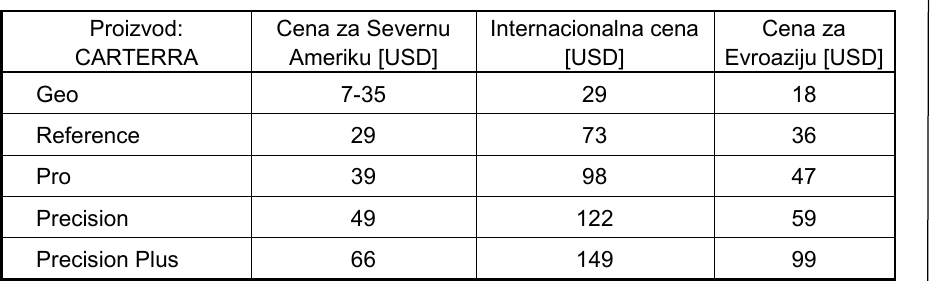
U tabeli 7 prikazana je ta č nost pozicioniranja, srednja greška i mo- gu ć nost koriš ć enja proizvoda IKONOS u